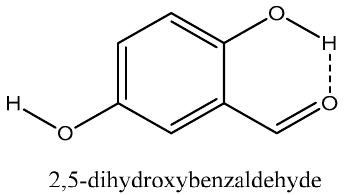
Figure 5. Intramolecular H-bonding of 2,5-dihydroxybenzaldehyde. Isovanillin can be directly compared to vanillin and 3-hydroxybenzaldehdye and appears to be another outlier. Isovanillin possesses both a lower P sat and a lower partial charge of the phenolic carbon than both vanillin and 3-hydroxybenzaldehdye.